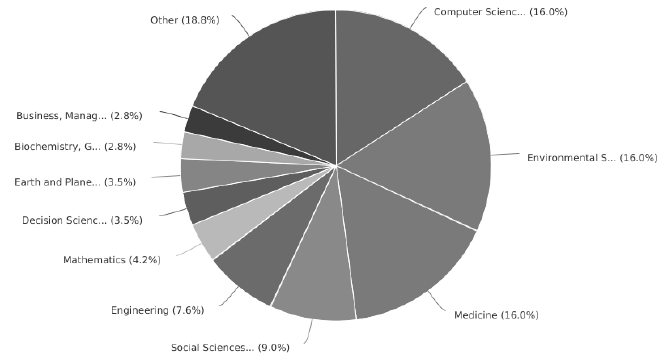
Figure 2. Areas of publication with multi-criteria.